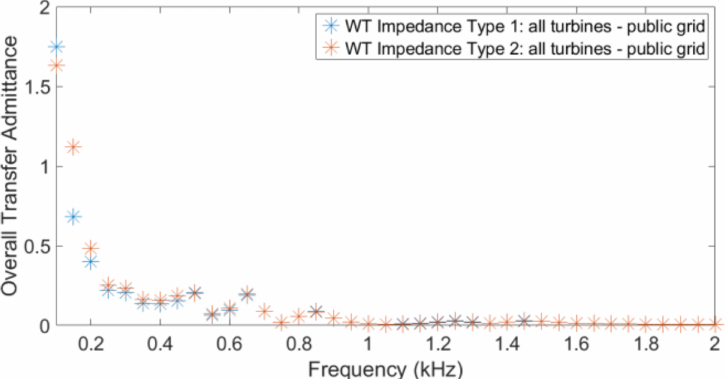
Figure 15. Impact of wind-turbine impedance on overall transfer admittance (A/V) from turbine to public grid: 5-turbine wind power plant.